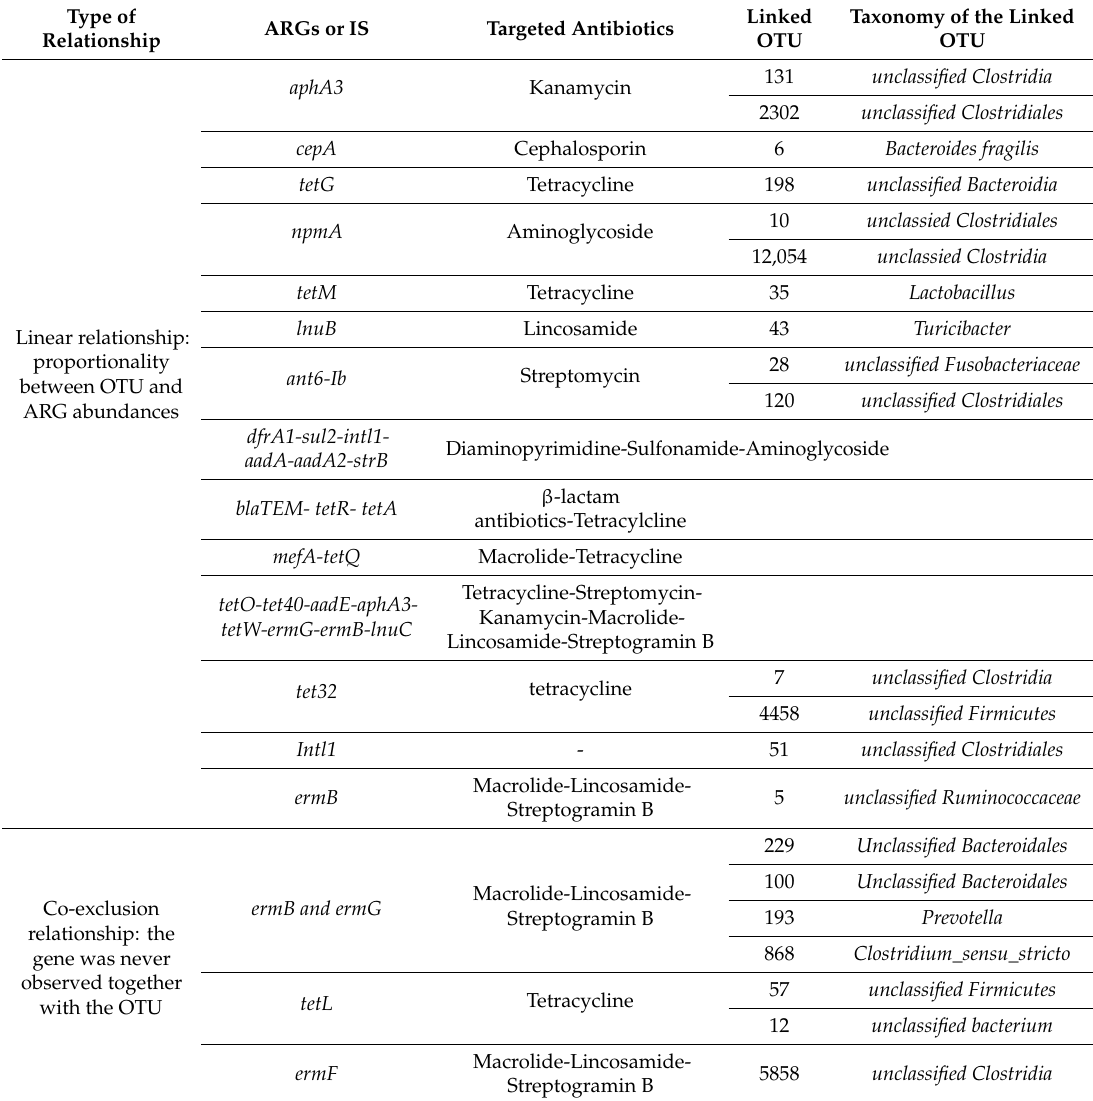
Table 3. Remarkable links between OTUs and ARGs at